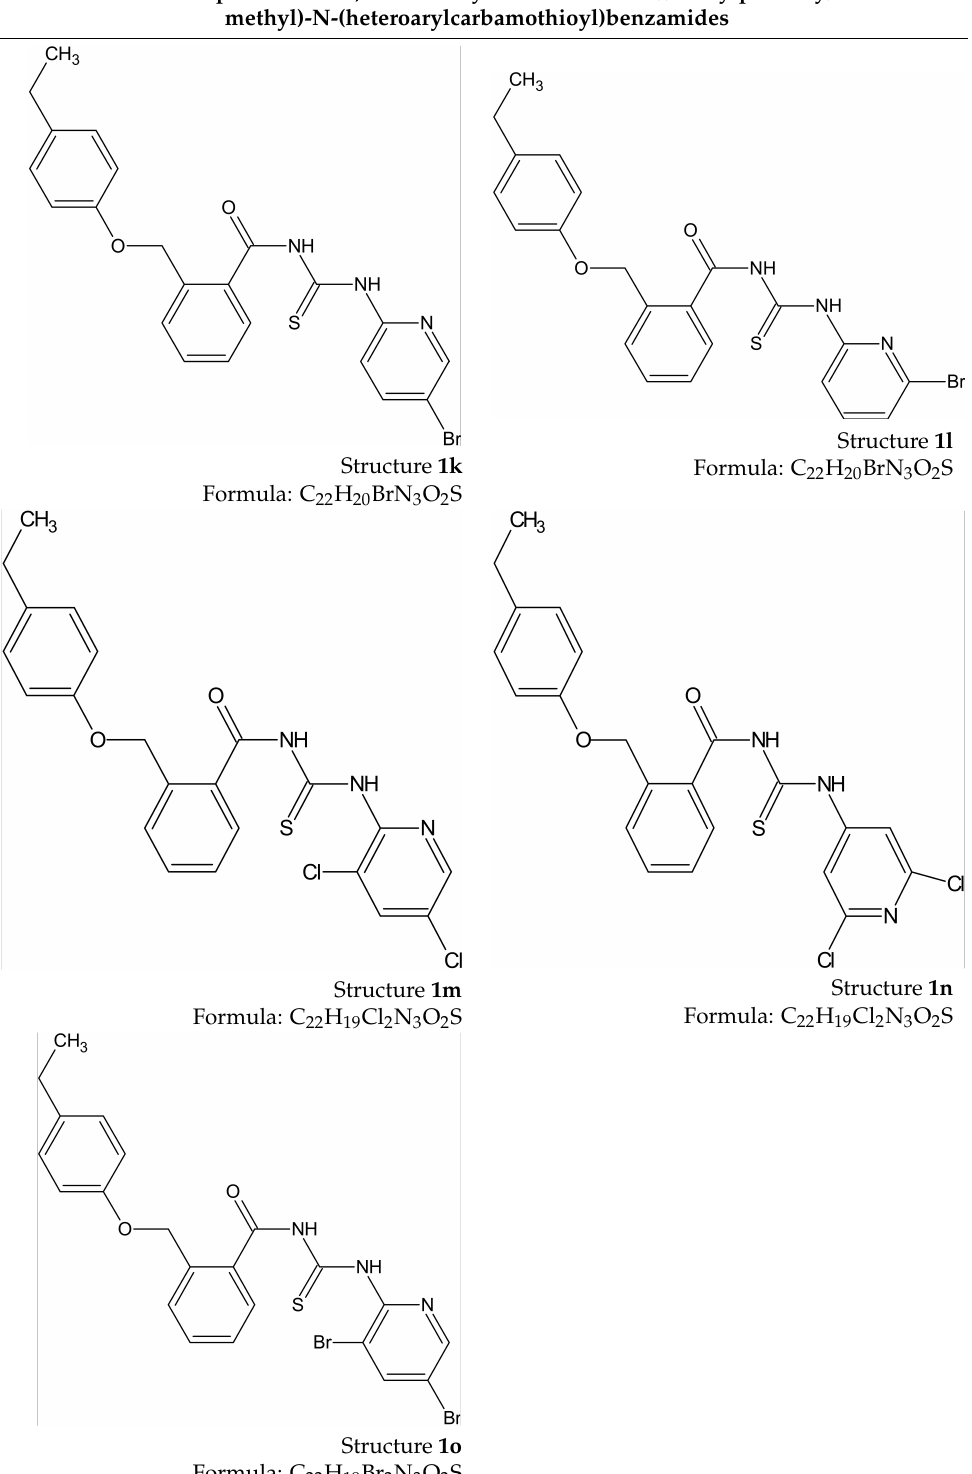
Table 1. Cont . The Compounds 1a–1o, Chemically Derived from